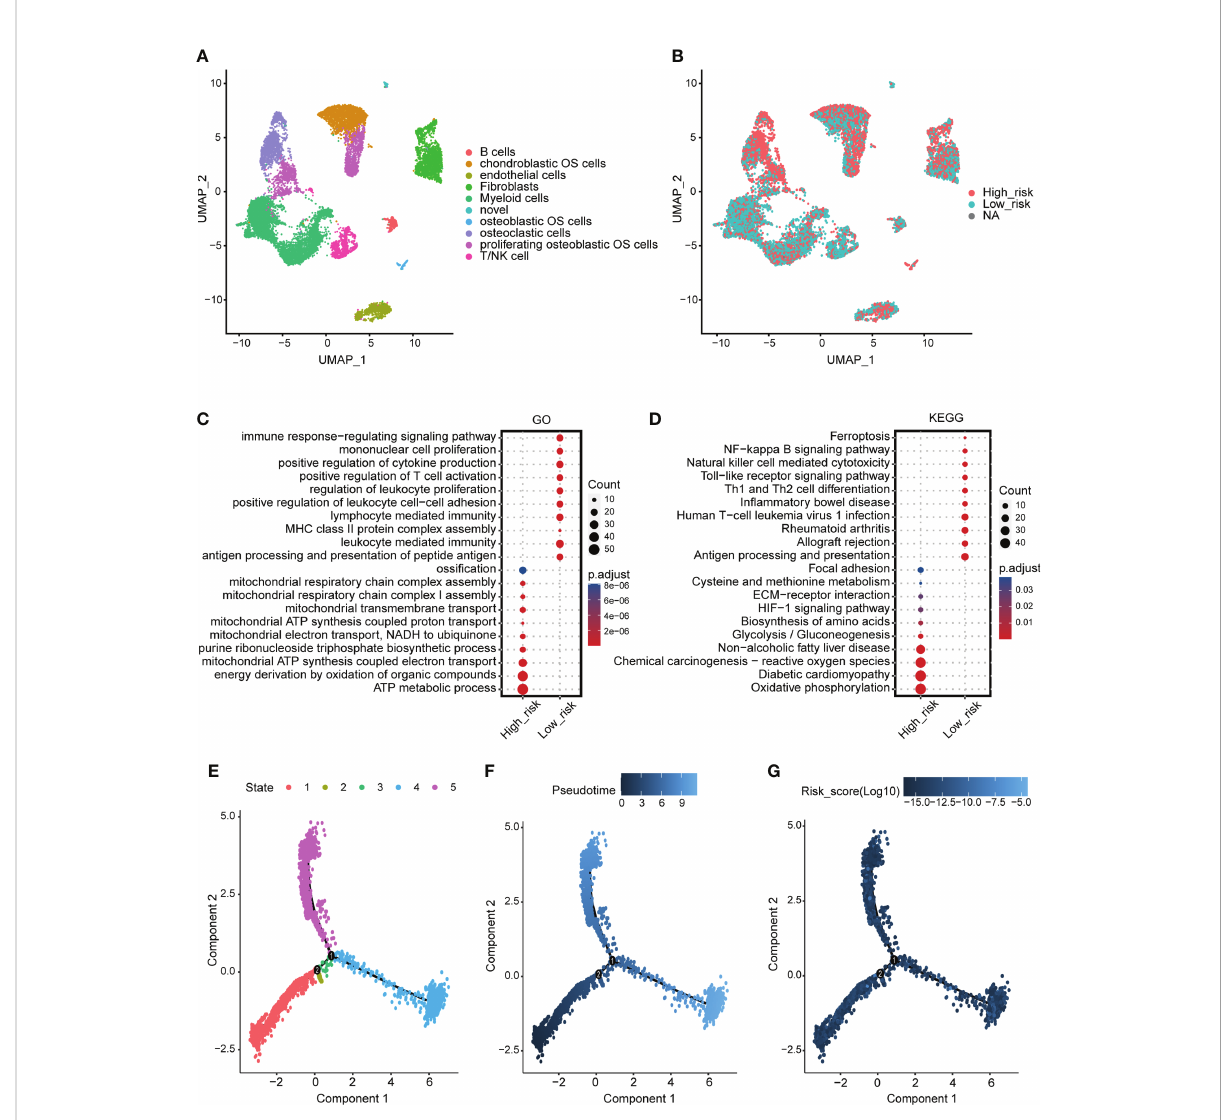
FIGURE 5 scRNA-seq analysis for the mitochondria-related signature. (A) The identi fi ed cells in the tumor microenvironment of osteosarcoma. (B) The levels of the mitochondria-related signature score in identi fi ed cells. (C) GO enrichment analysis for the DEGs between the two mitochondria- related signature score groups of osteosarcoma cells. (D) KEGG enrichment analysis for the DEGs between the two mitochondria-related signature score groups of osteosarcoma cells. (E) Different cell states of the pseudotime trajectory analysis on the osteosarcoma cells. (F) Pseudotime pattern of the pseudotime trajectory analysis on the osteosarcoma cells. (G) The mitochondria-related signature score of the pseudotime trajectory analysis on the osteosarcoma